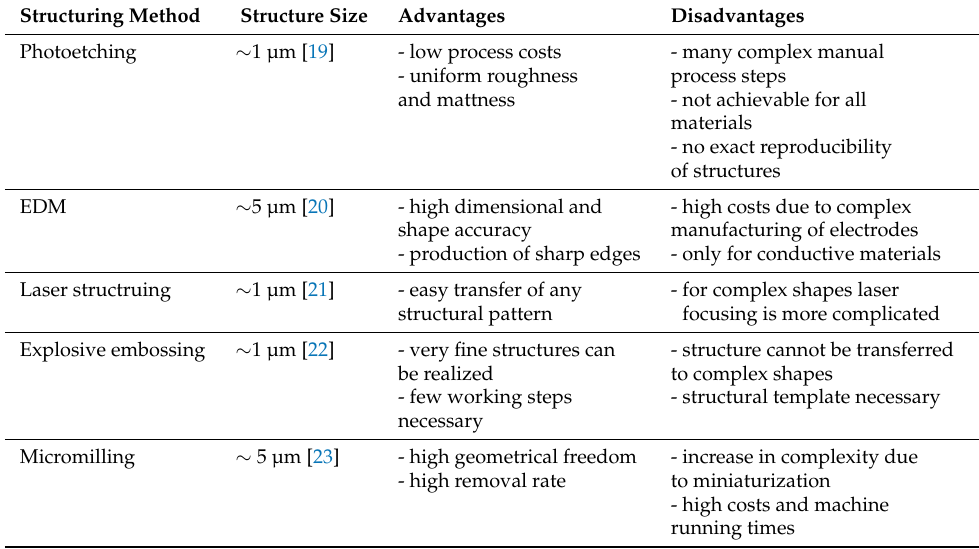
Table 1. Overview of the process variants for structuring injection molds.